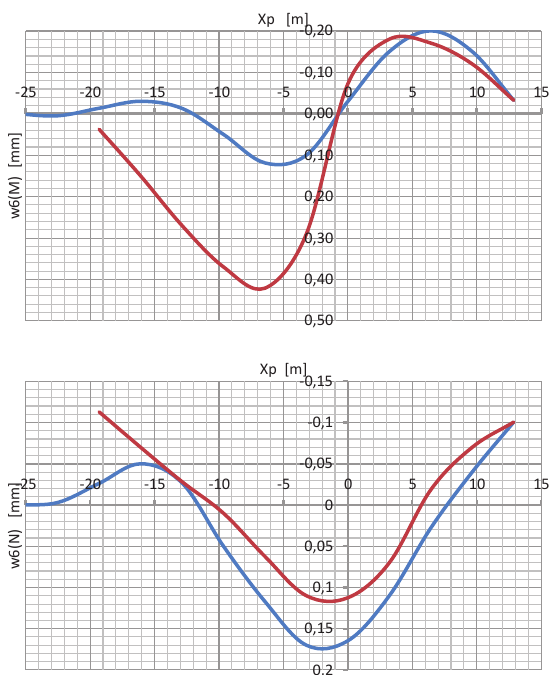
Figure 8: Comparison of shell crown deflections obtained by different measuring techniques.